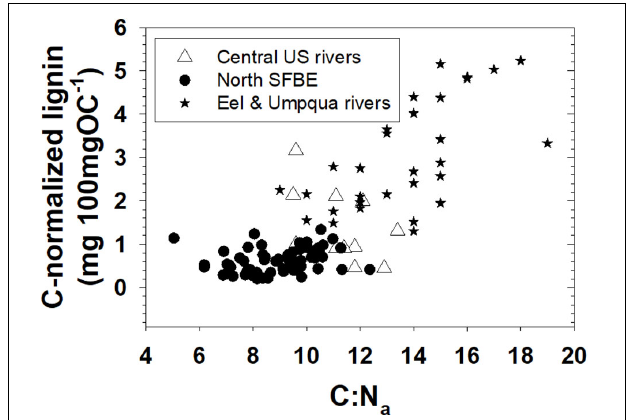
FIGURE 5 | Carbon-normalized lignin yields, (cid:51) 8 , vs. atomic ratio of carbon to nitrogen, C:N a , for this study in comparison to a survey of rivers across the US (Onstad et al., 2000) and the Eel and Umpqua rivers (Goñi et al., 2013) as comparative rivers to the Sacramento River headwaters.